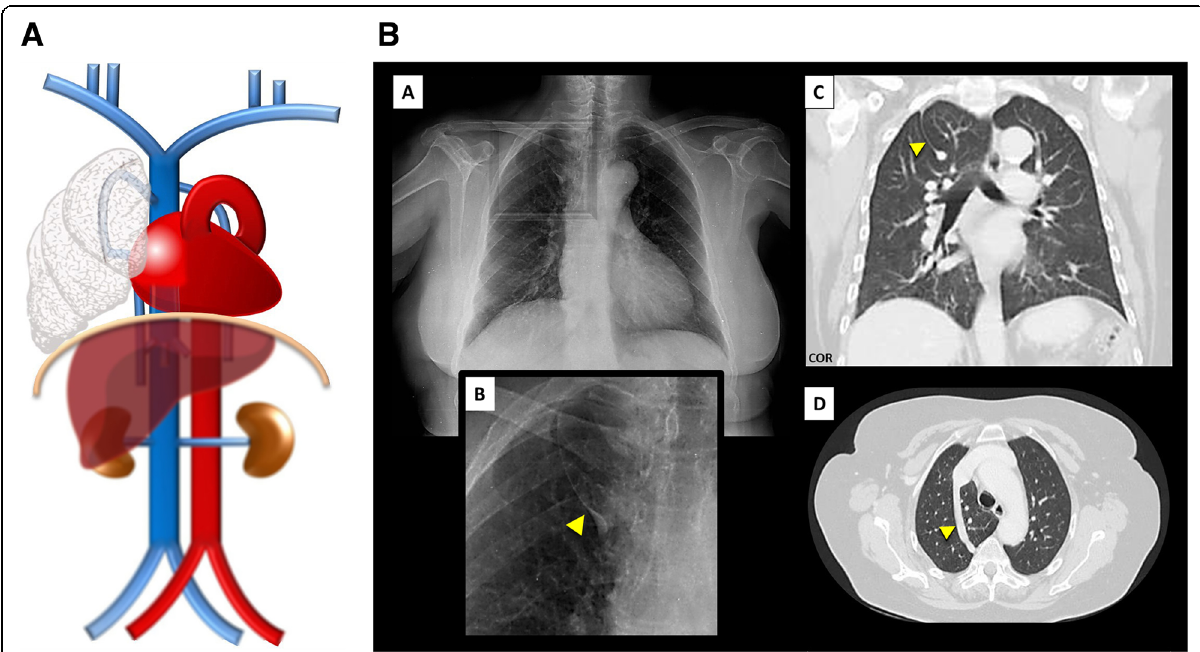
Fig. 14 a Azygos fissure and lobe schematic. Resulting from an abnormal course of the azygos vein in the apex of the right lung subsequent to a failure of migration. b Azygos fissure and lobe imaging. Azygos fissure and lobe, as seen on chest X-ray [A, B — magnification view], as a line that crosses the apex of the right lung ending in a tear shape, and on thoracic CT scan on coronal [C] and axial [D]